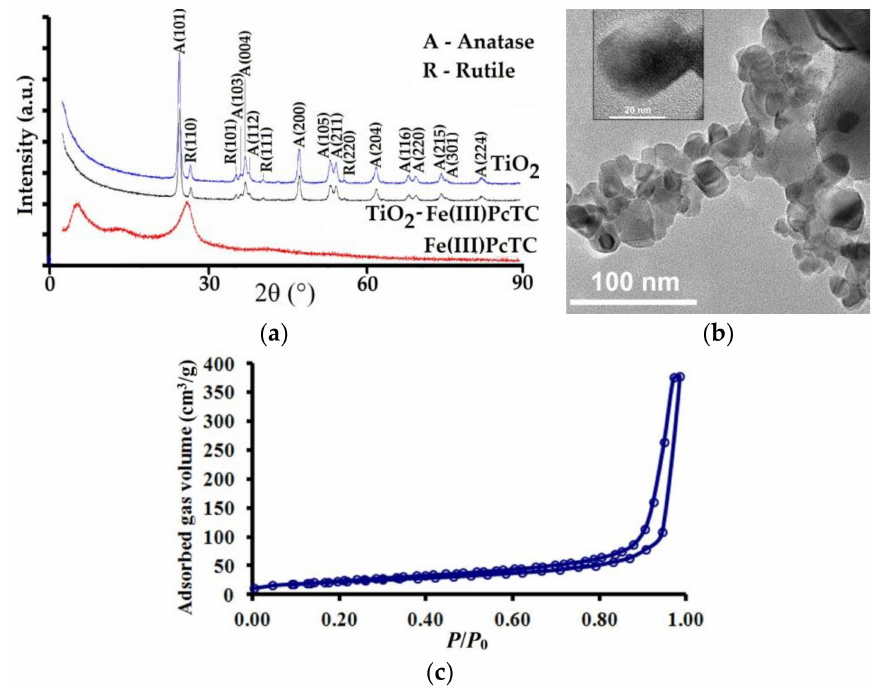
Figure 2. ( a ) X-ray diffraction (XRD) pattern; ( b ) TEM image and ( c ) nitrogen adsorption-desorption isotherm of P25-Fe(III)PcTC. P / P 0 is the ratio between the equilibrium and the saturation pressure of